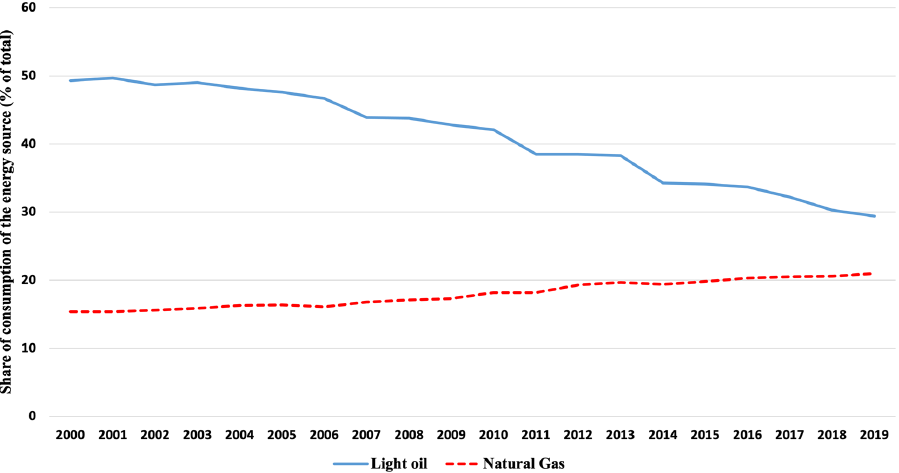
Figure A1. Final fossil-fuel consumption as a share of total final energy consumption used for heating (light oil, gas, coal, electricity, wood, district heating, and renewables in TJ) by Swiss households. Sources: overall energy statistics (Table 17a, [42]).